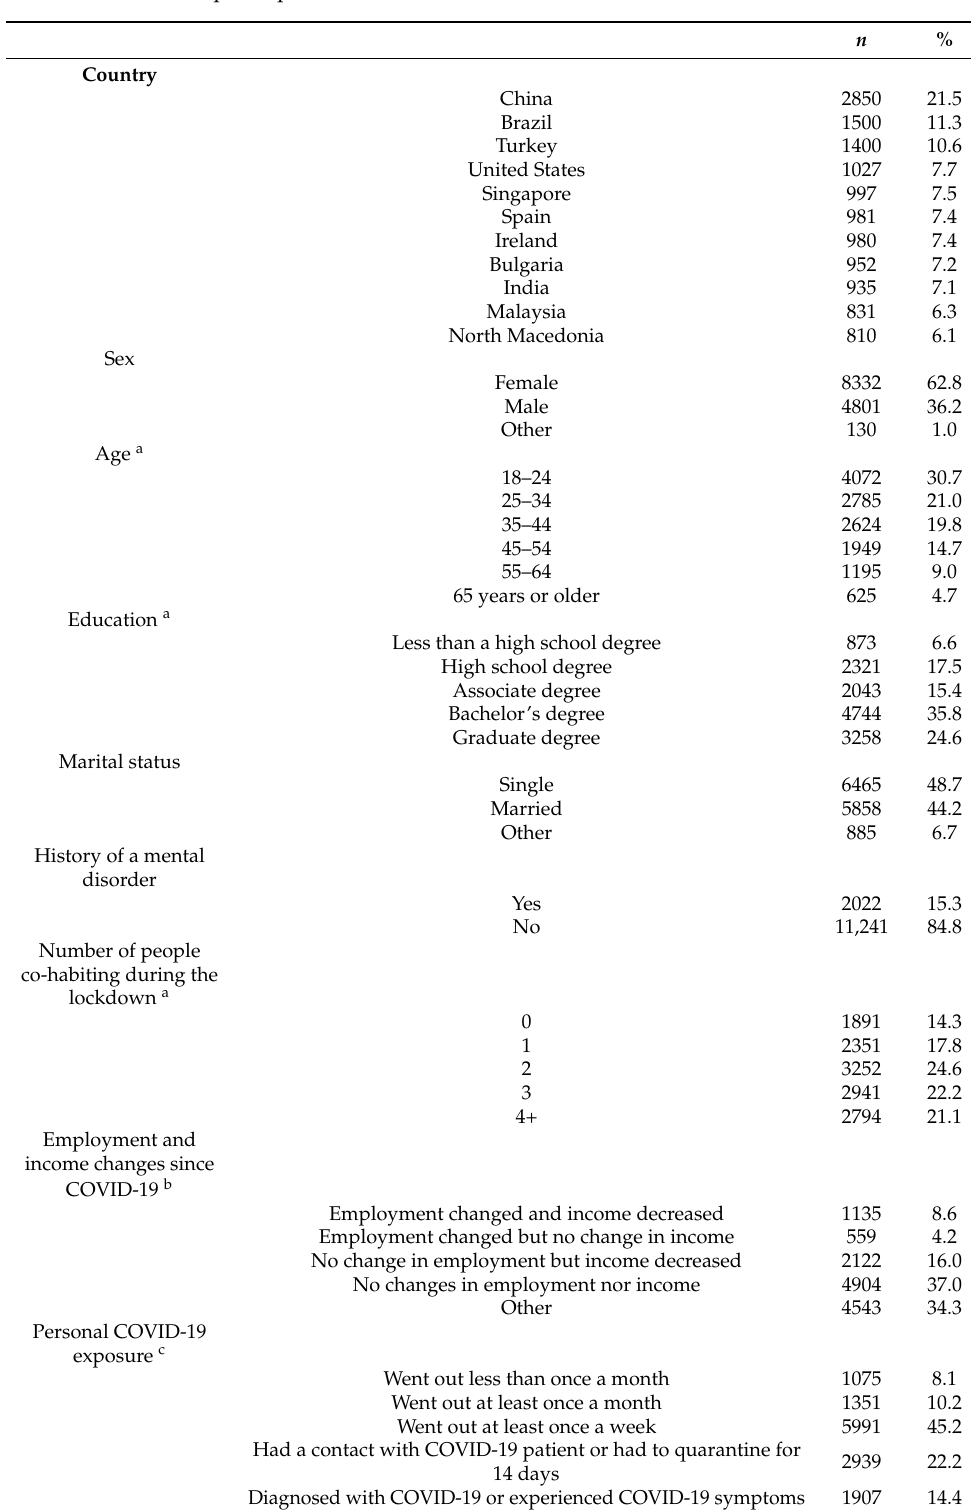
Table 1. Demographic characteristics and COVID-19 exposure of participants in the 11 participating countries, n = 13,263